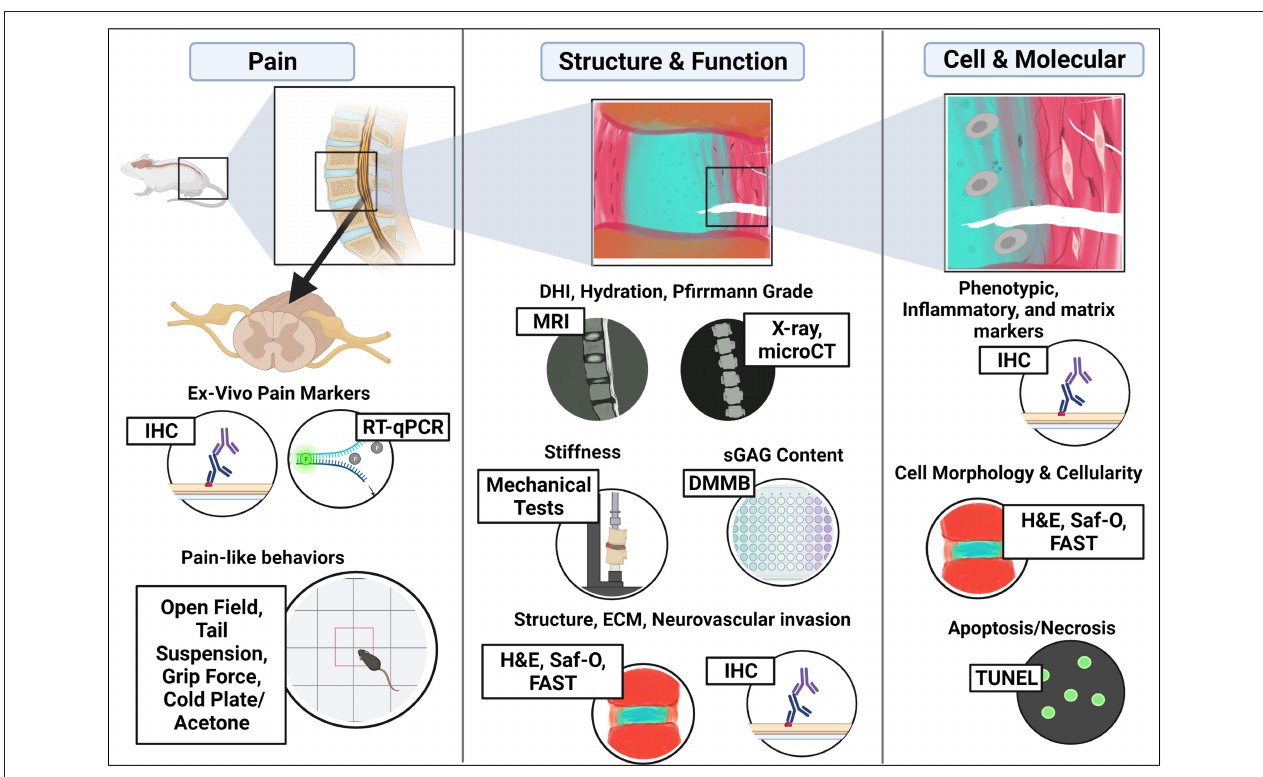
FIGURE 3 | Critical assessments in mouse models of IVD degeneration for regenerative therapies used to treat Low Back Pain. Figure created using BioRender.com.